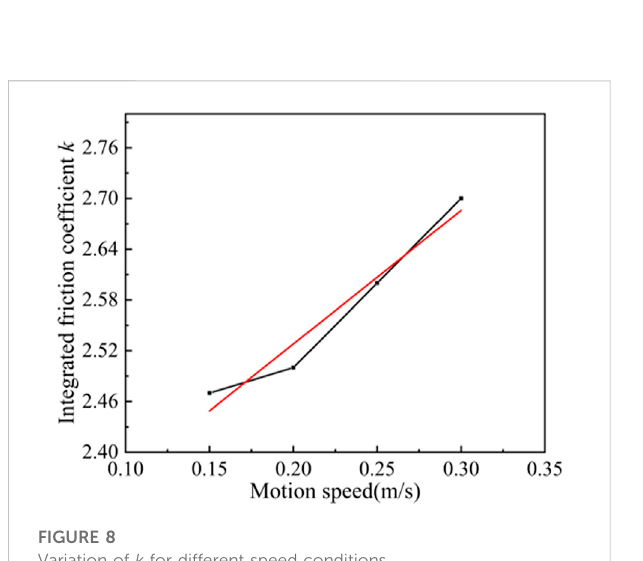
FIGURE 8 Variation of k for different speed conditions.